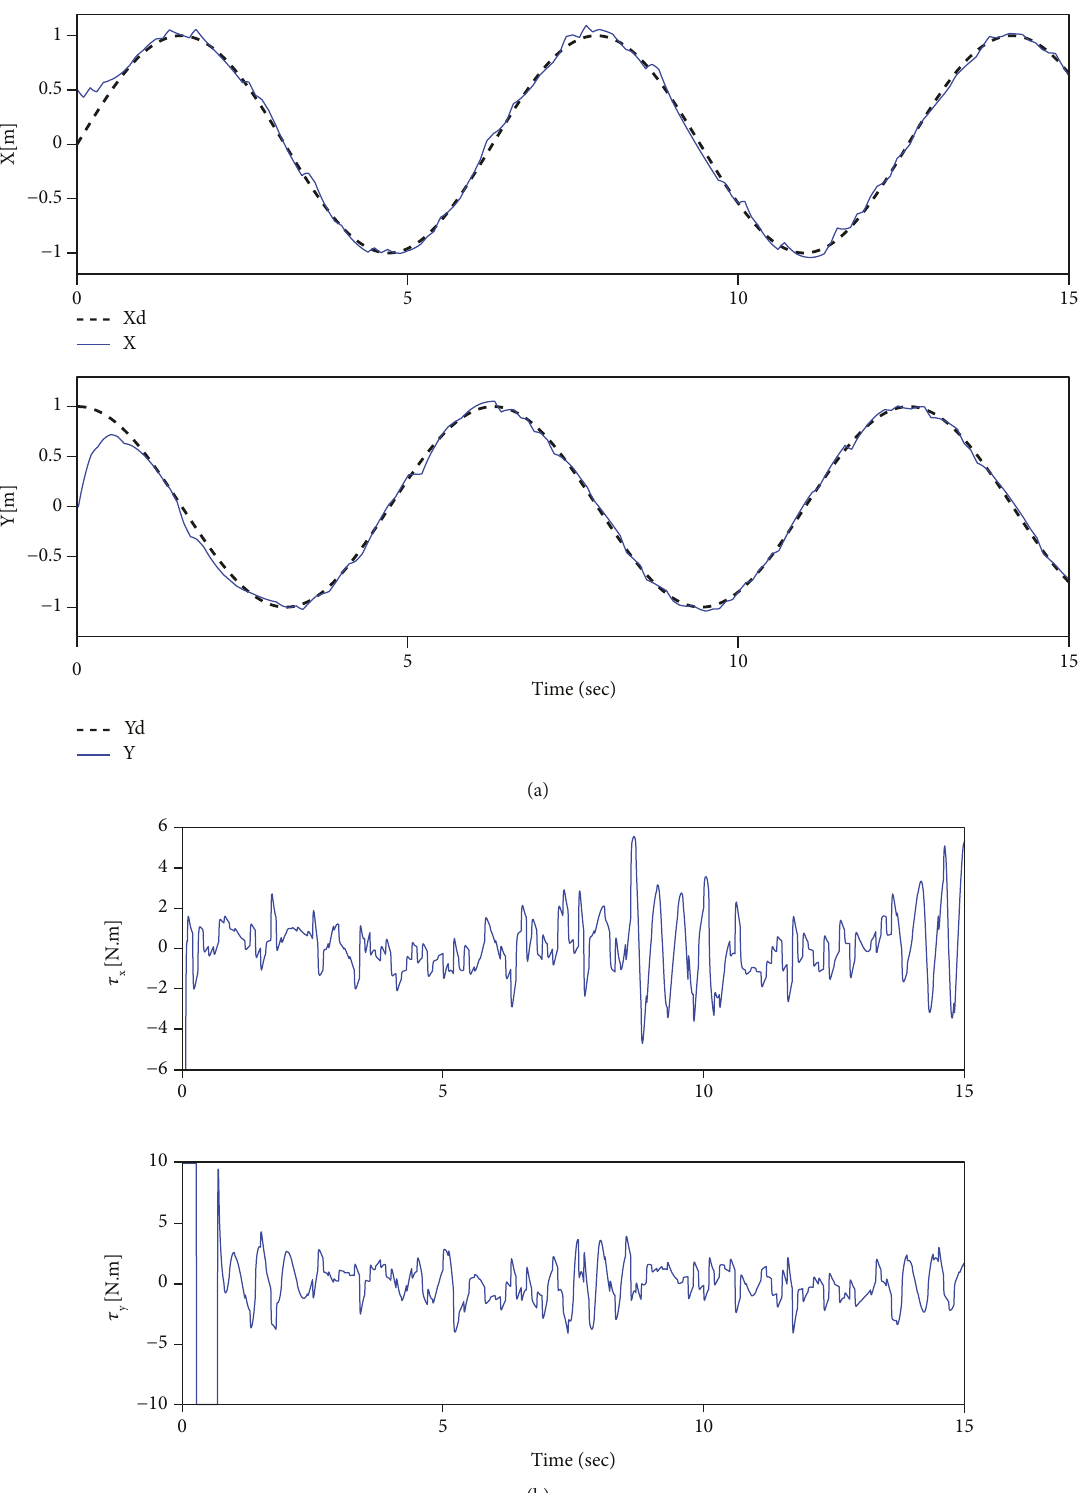
Figure 9: (a) Robot trajectory tracking performance around the X and Y directions in the presence of measurement noise. (b) Input torques applied to the robot in the presence of the measurement